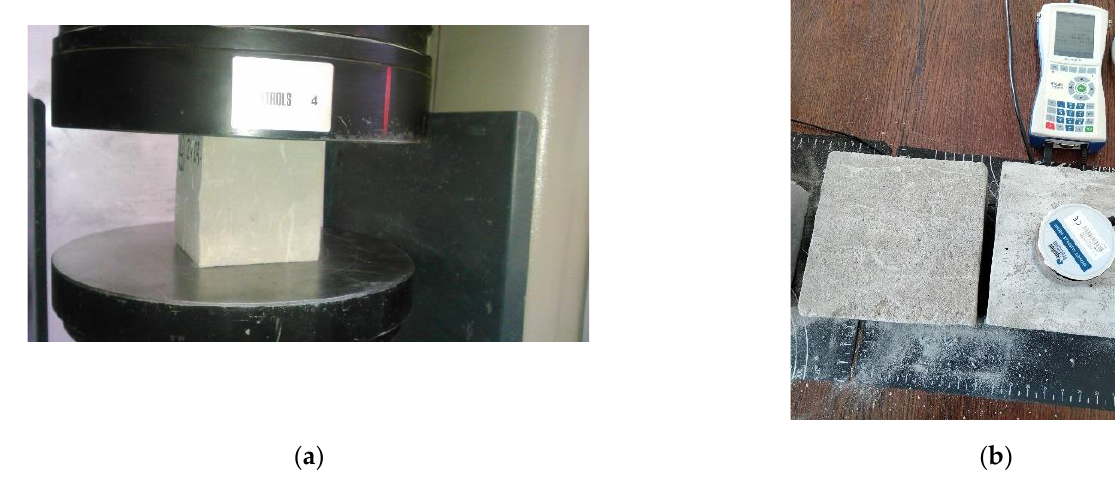
Figure 6. The measurements of the foam concrete ( a ) mechanical and ( b ) thermal properties.